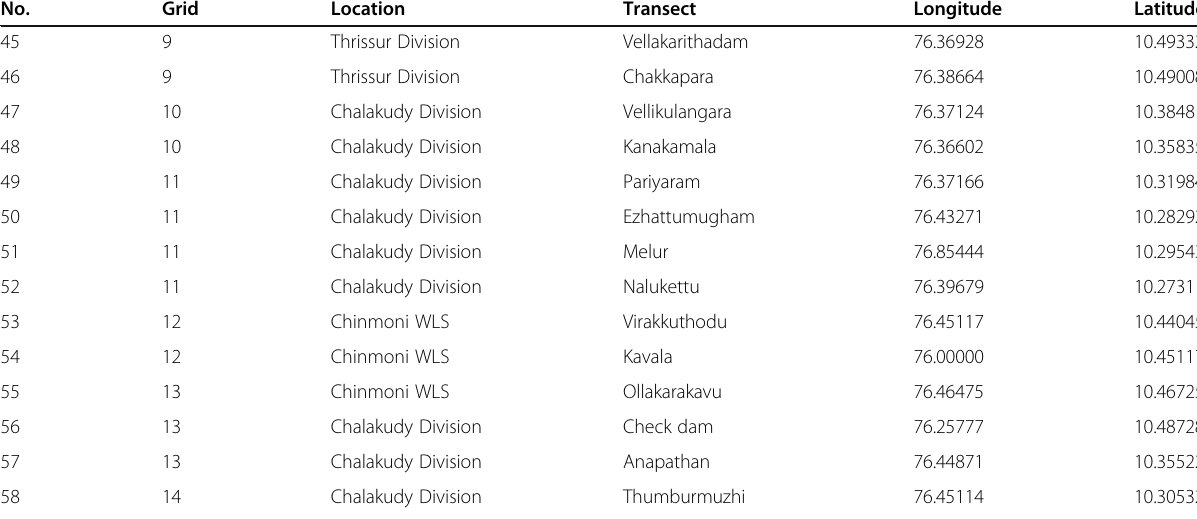
Table 1 Geographic coordinates of transects sampled in 30 grids of study area (Continued)